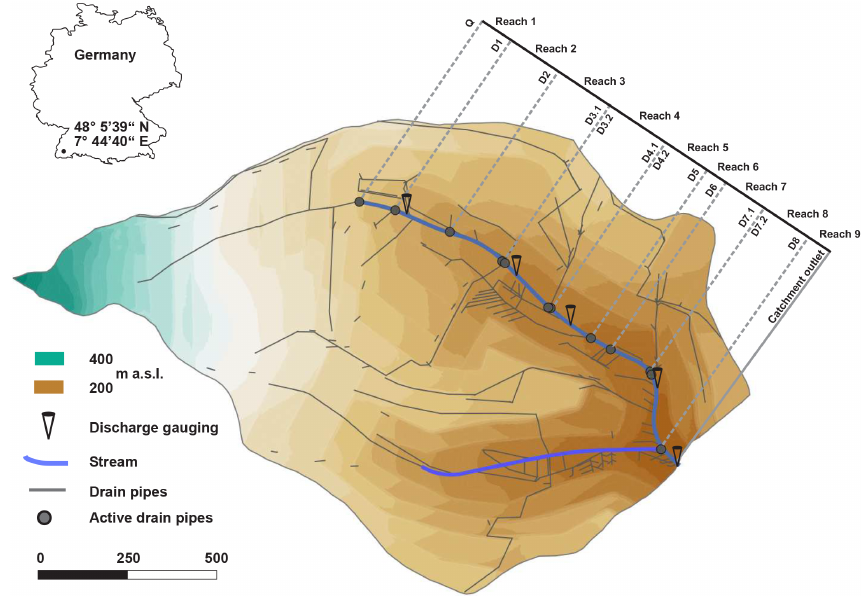
Figure 1. Topographical map of the Löchernbach catchment. The sharp elevation steps in the map represent the vineyard terraces within the catchment. Locations of active drainpipes and stream reaches are marked (dashed lines) with the names referred to throughout the